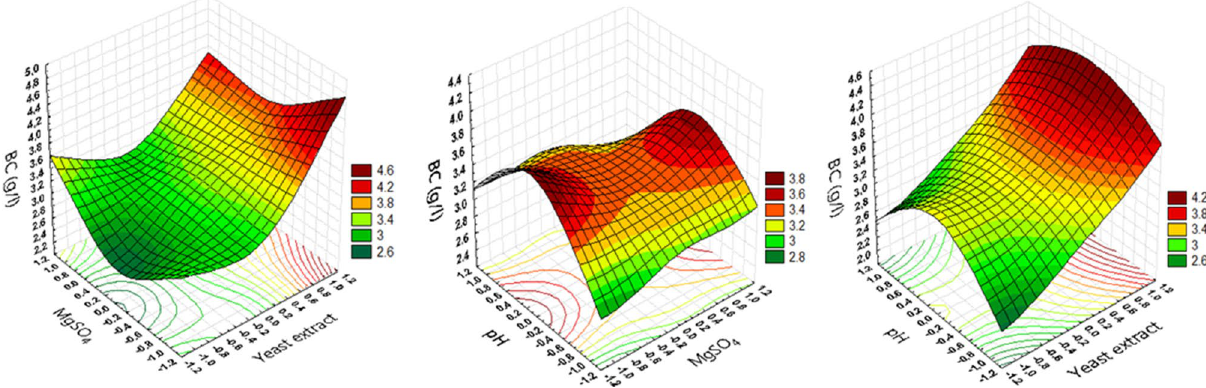
Figure 5. Three-dimensional surface plots representing the effect of yeast extract, MgSO 4 , and pH on the BC production by L. plantarum